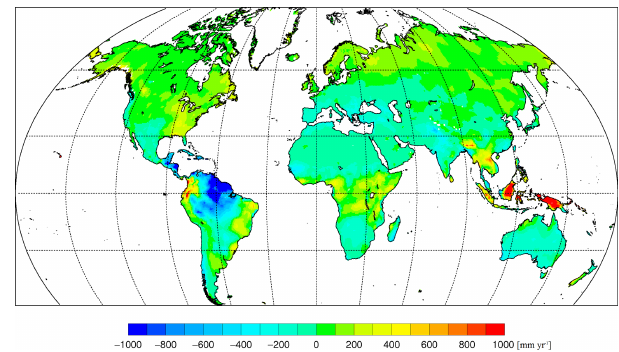
Figure A3. Precipitation change during the 21st century simulated with MPI-ESM-LR under RCP 8.5. Shown is the difference be- tween average values computed for 1990–2000 and 2090–2100. Data were bias-corrected following Ahlström et al. (2013).